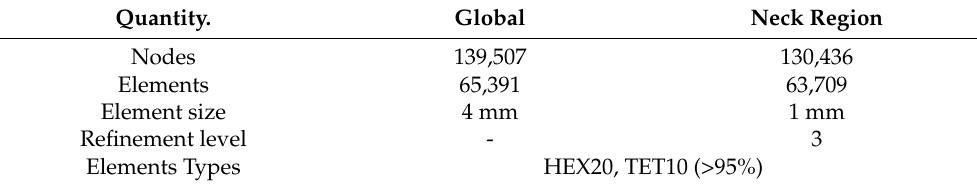
Table 6. Analysis